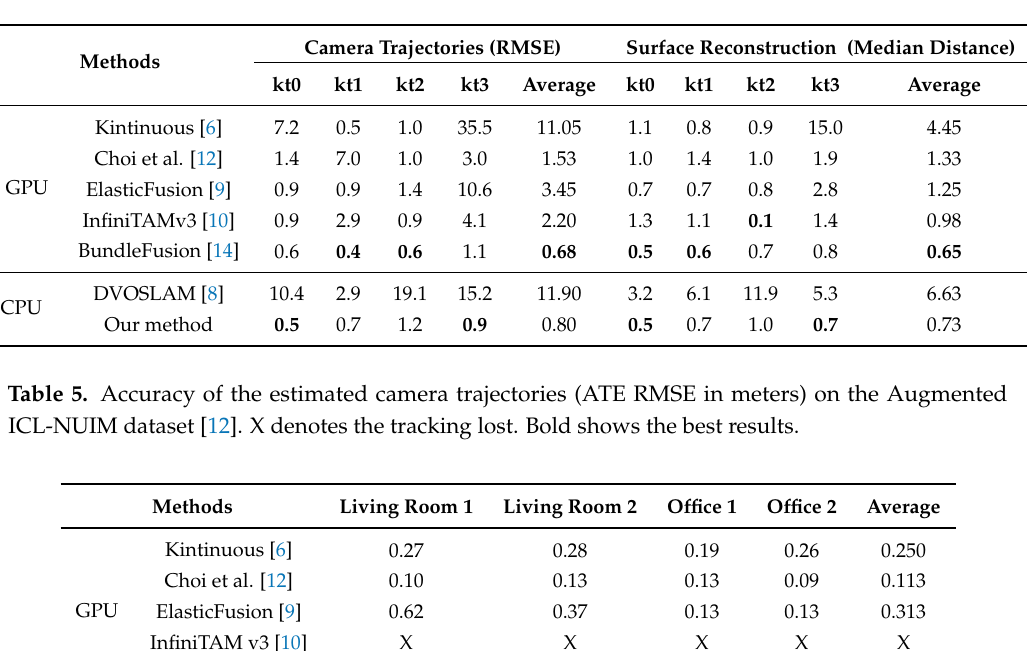
Table 4. Accuracy of the estimated camera trajectories (ATE RMSE in centimeters) and surface reconstruction (median distance in centimeters) on the ICL-NUIM living room sequences [38]. Bold shows the best results.